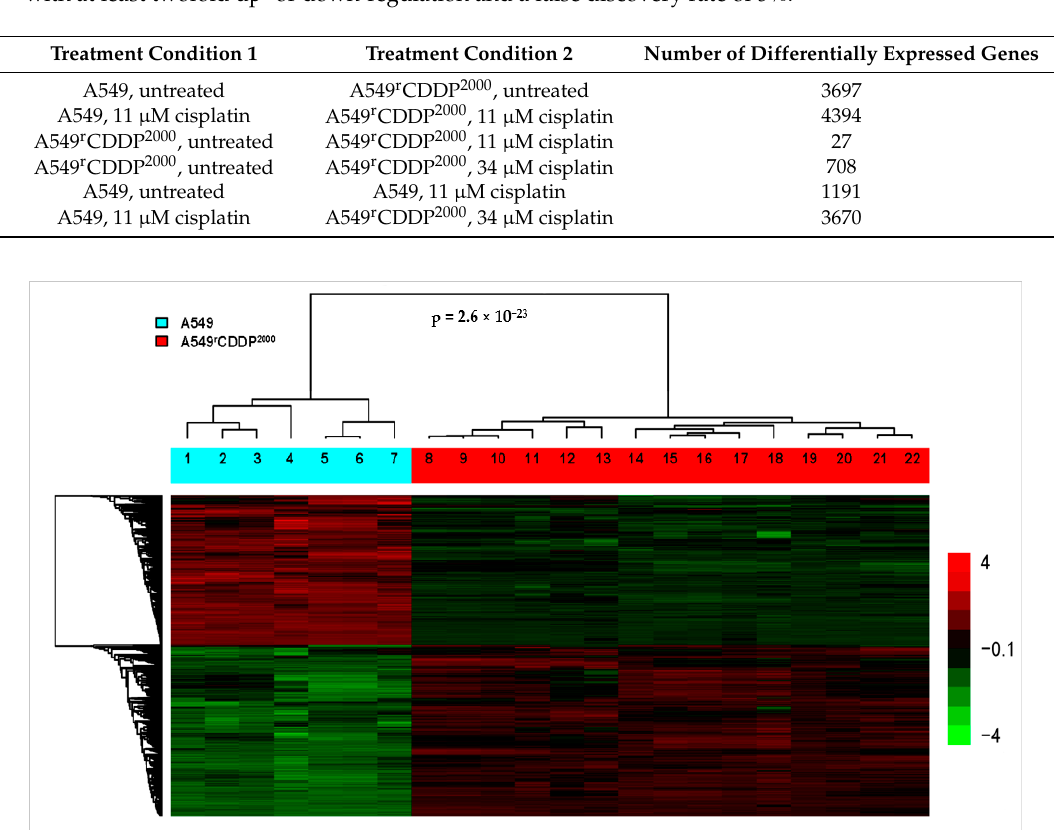
Table 1. Number of differentially expressed genes, compared as treatment condition 1 vs. condition 2 with at least twofold up- or down-regulation and a false discovery rate of 5%.